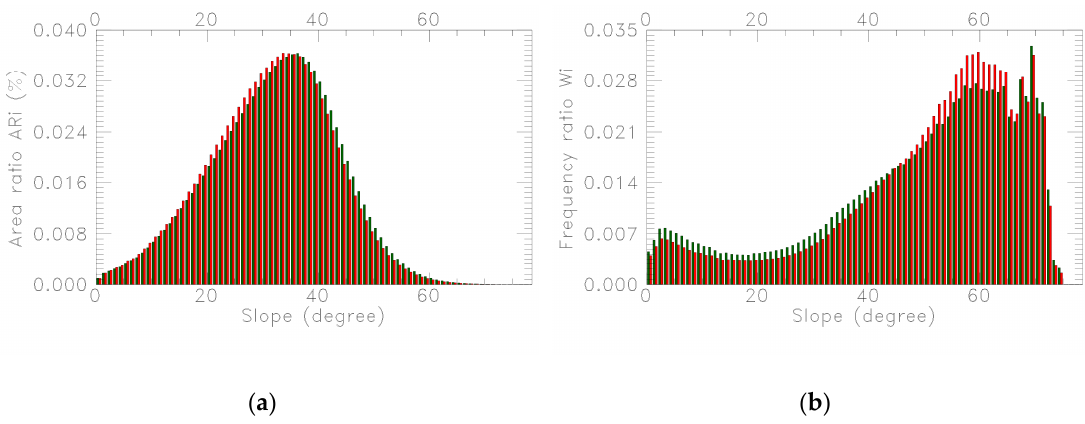
W Slope (green bars) vs. AR (red bars), and ( b ) Slope